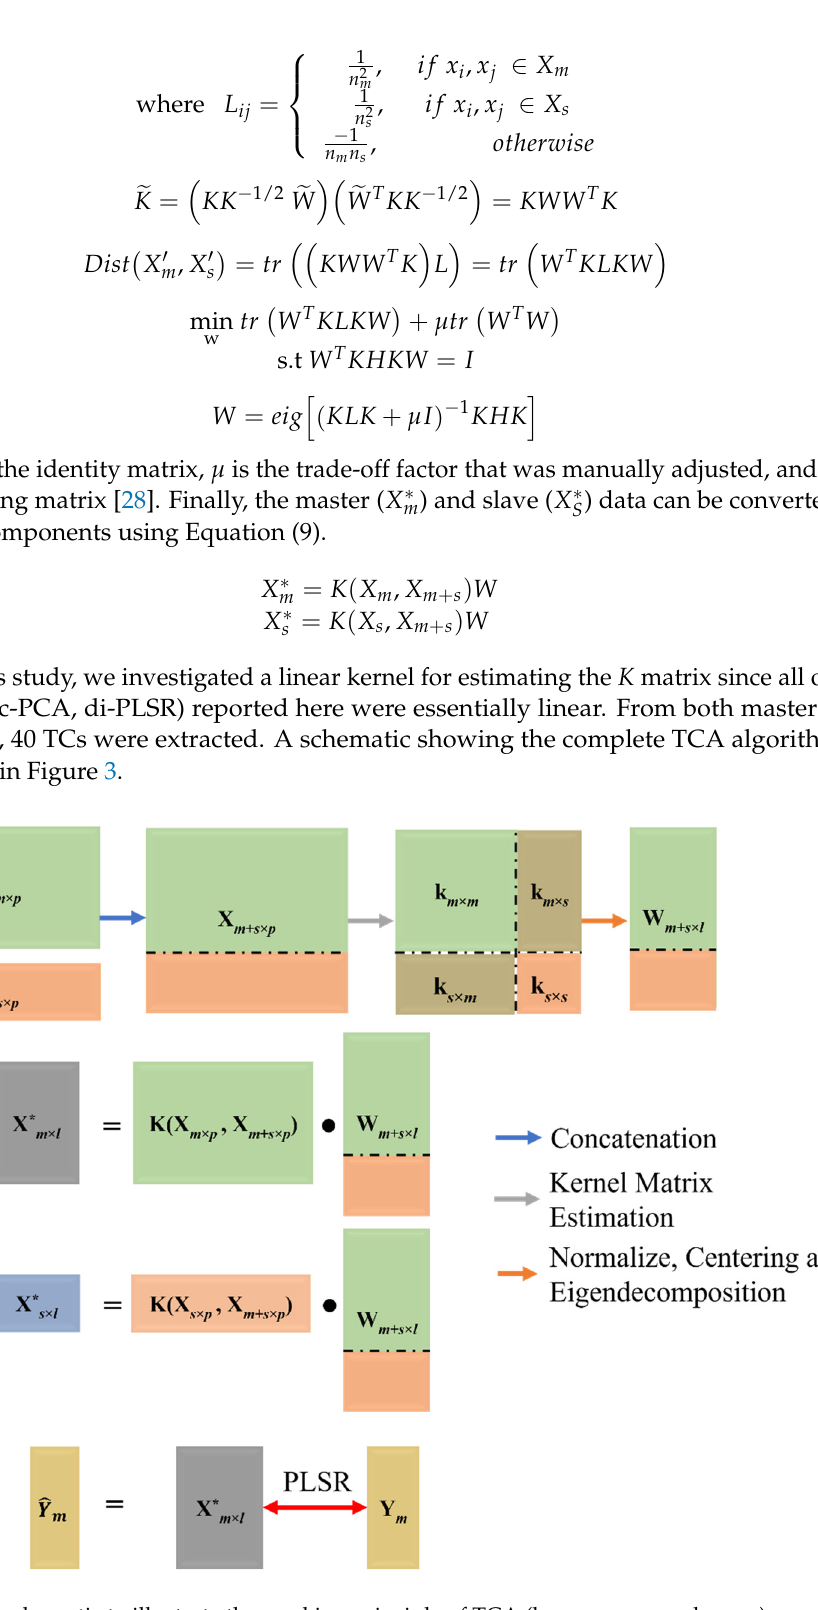
Figure 3. A schematic to illustrate the working principle of TCA (here, m = n m and s = n s ).